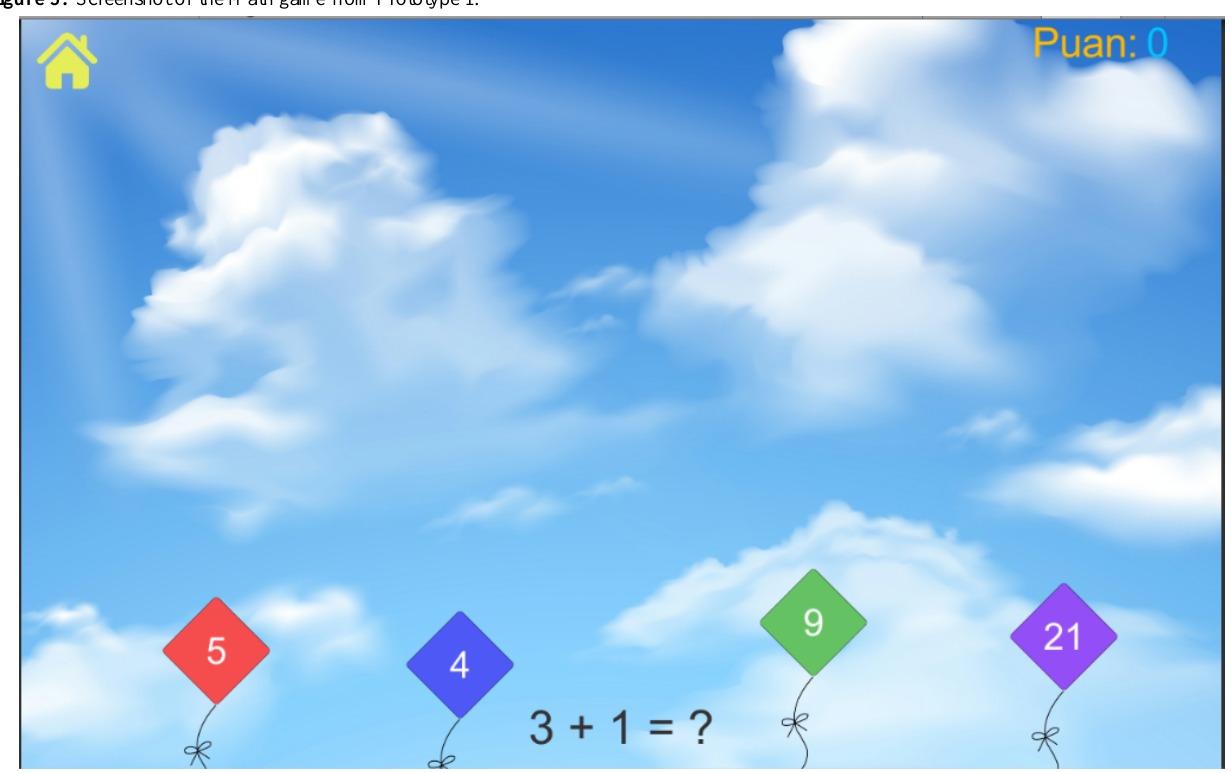
Figure 5. Screenshot of the Math game from Prototype